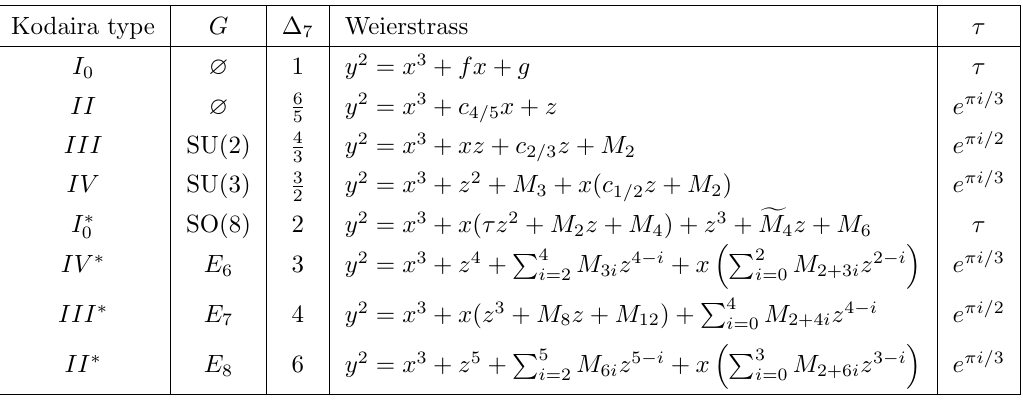
Table 5. The eight scale-invariant Kodaira singularities with the corresponding Weierstrass forms. We have included explicitly all the deformations including the relevant couplings c i and mass parameters M i (where i denotes the scaling dimension) of the corresponding four-dimensional theory living on a probe D 3 brane. The coordinate z parametrizes the base of the Weierstrass i.e. the transverse plane to the